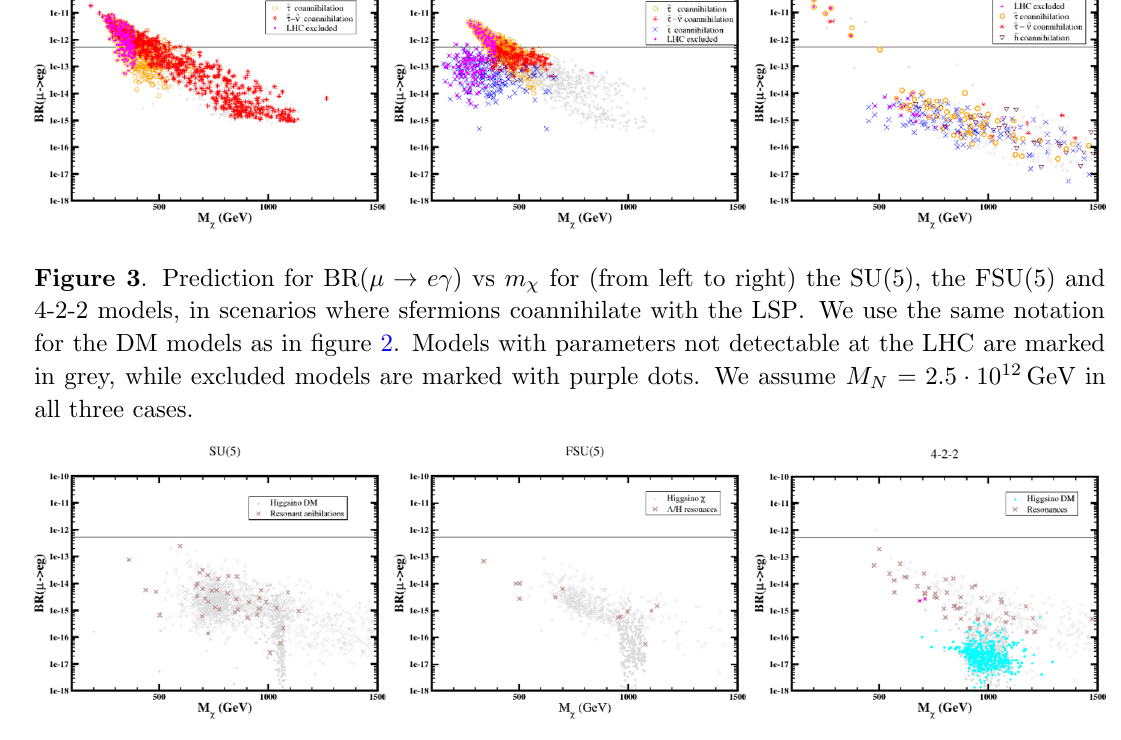
Figure 4 . As in (cid:12)gure 3, for Higgsino DM and for models of resonant coannihilation. In (cid:12)gure 3 and following (cid:12)gures, we denote points of the same DM class with the same symbol as in (cid:12)gure 2 but changing the colour according to the LHC prospects of the model: points of categories (i) and (ii) retain the same colour as in (cid:12)gure 2, adding a magenta dot for the excluded ones, whereas points of category (iii) are drawn in